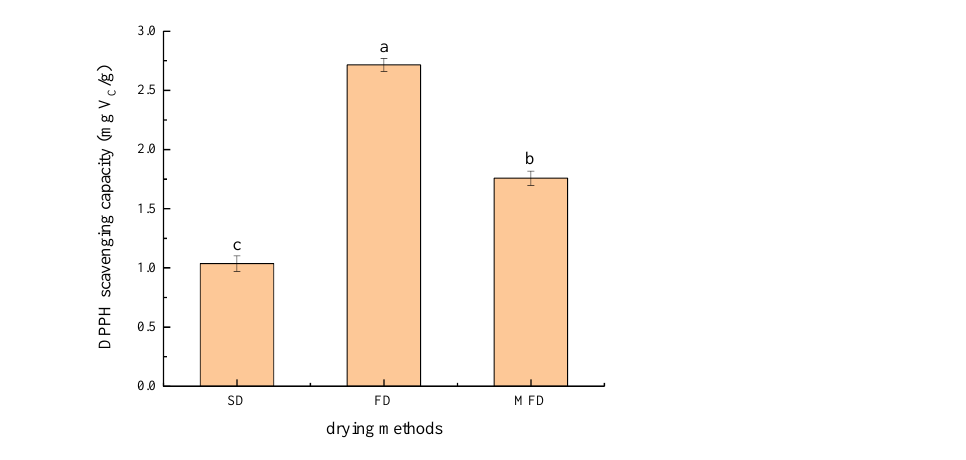
Figure 5. Antioxidant activity of UA-loaded chitosan nanoparticles dried by different methods. a–c Values with different superscript letters in the figure are significantly different ( p < 0.05) on the basis of Tukey’s multiple-comparison test.